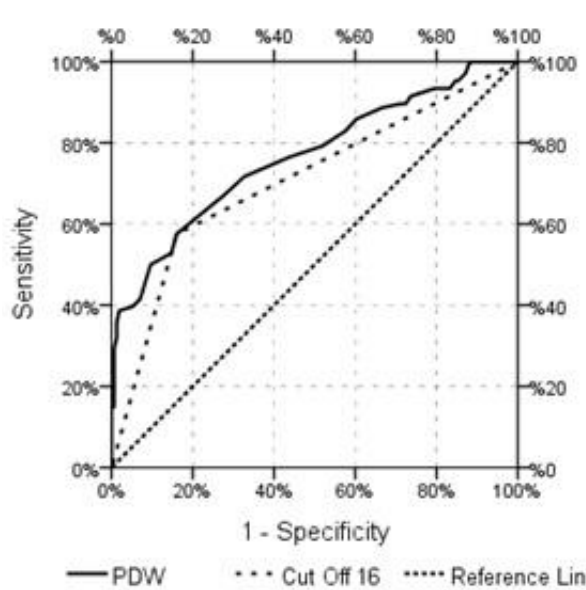
Fig. 1 – Receiver operator characteristic curve of platelet distribution width (PDW) in detecting patients with saphenous vein graft failure.